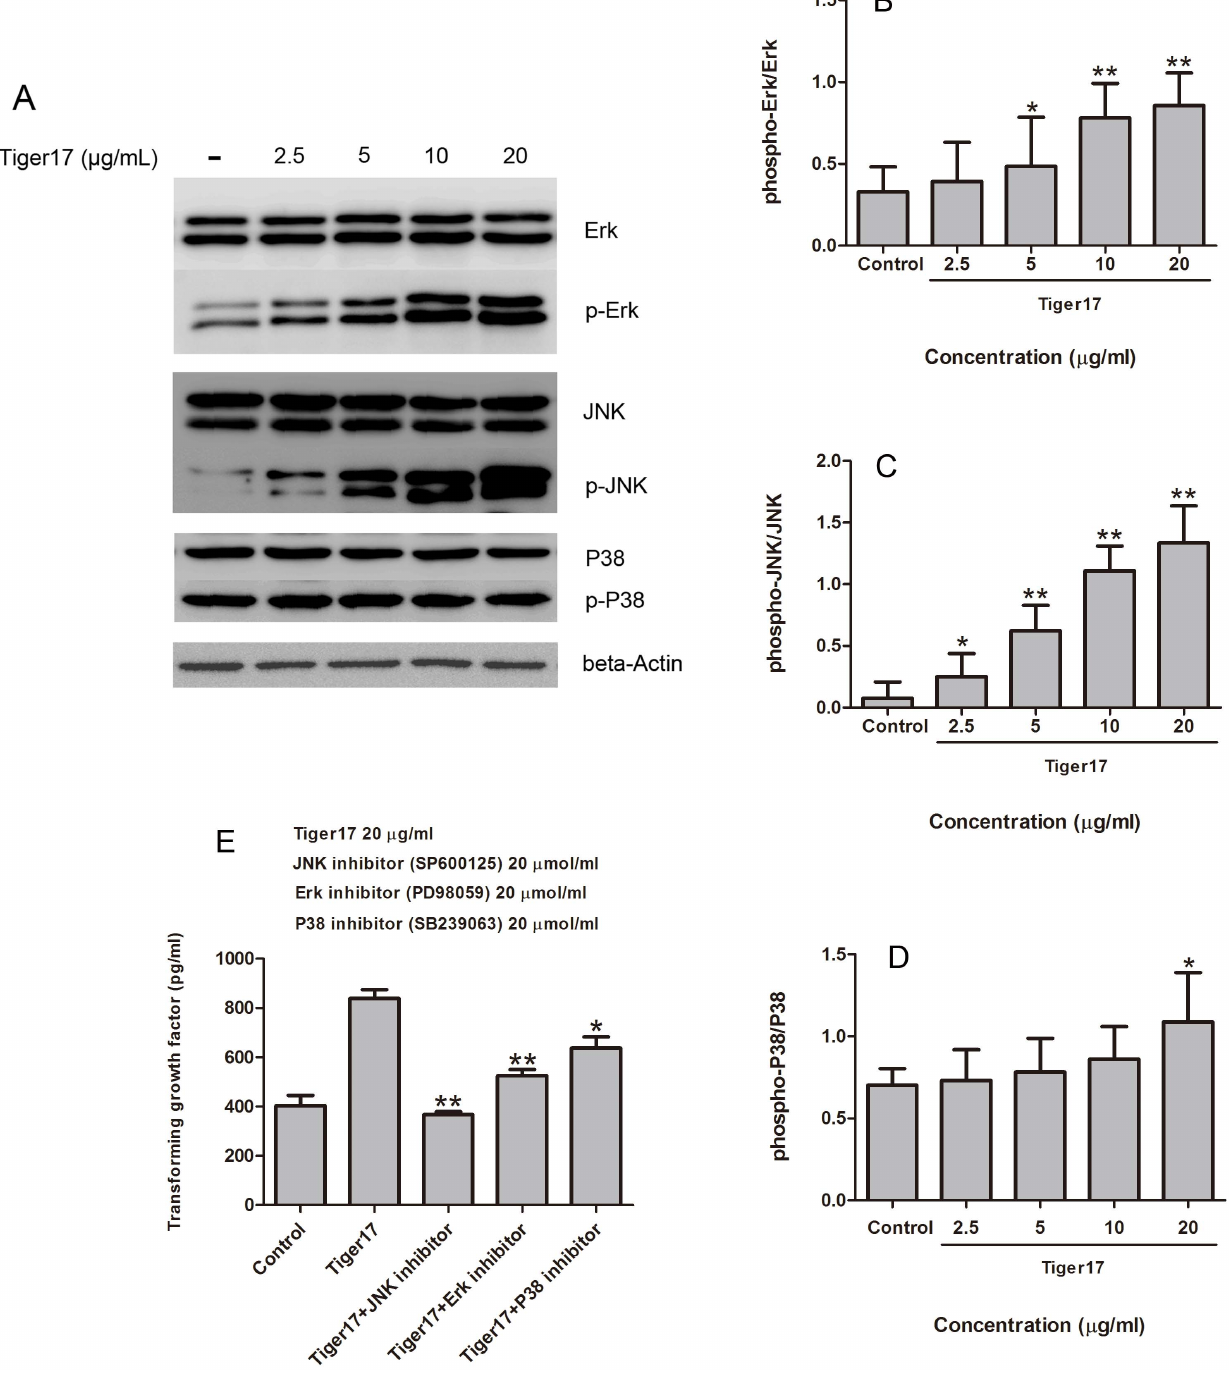
Figure 5. Effects of tiger17 on the MAPKs signal pathway. (A) Raw 264.7 cells were treated with the indicated concentrations of tiger17 (2.5, 5, 10, 20 m g/ml) or vehicle; Western blotted for total or phospho-JNK, Erk or P38 was performed. b -Actin was used as the internal control. (B, C, D) The band intensity of various inducer of MAPKs pathway=each phosphate-contents/homologous total-contents. (NIH, Image J). (E) After MAPKs pathway inhibitors were used, TGF- b 1 expression was decreased, even the same way tiger17 treatment. Values are the mean 6 SE of three independent experiments, *P , 0.05, **P , 0.01. doi:10.1371/journal.pone.0092082.g005 (Fig. 3C), which suggested that the therapeutic effect of tiger 17 was related to macrophages recruitment, instead of proliferation.